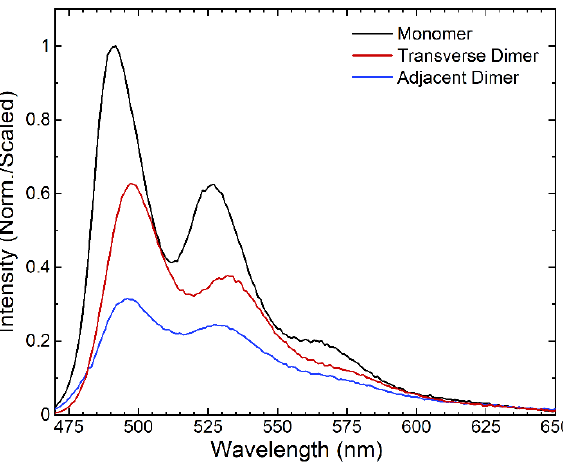
Figure 2. Relative fluorescence emission spectra of DNA-templated perylene monomer, transverse dimer, and adjacent dimer solutions. The fluorescence emission spectra were all scaled by dividing by the absorptance of the solution at the excitation wavelength (see, e.g., Experimental Methods). The monomer spectrum was subsequently normalized to the most intense emission feature. The transverse and adjacent dimer spectra were further scaled using the normalization factor determined for the